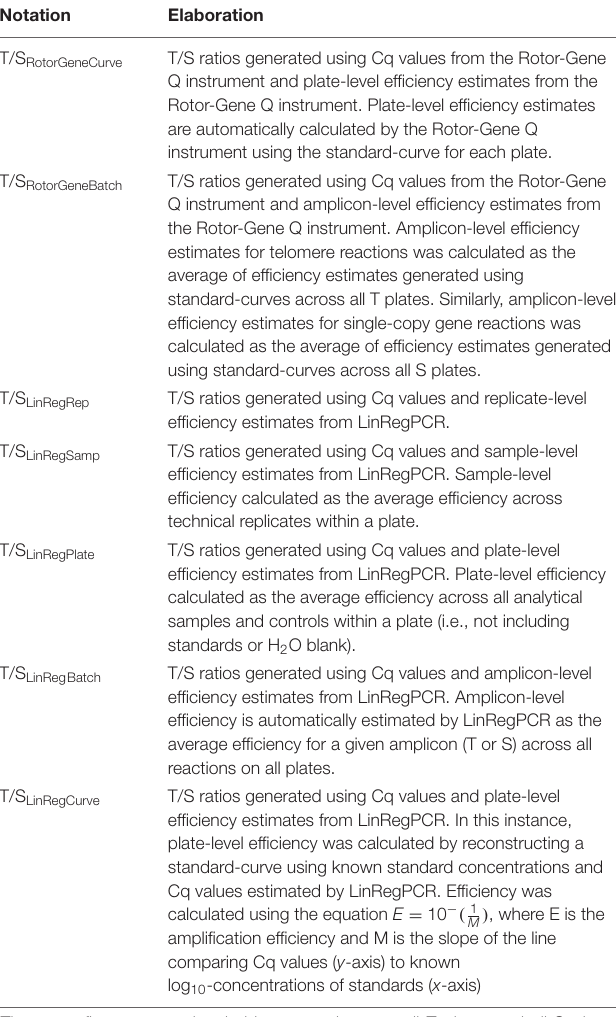
TABLE 1 | Summary of T/S ratio calculation